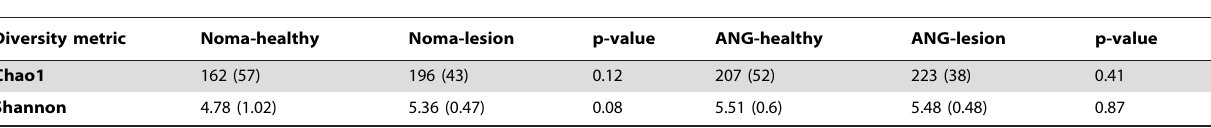
Table 1. Diversity comparisons between lesion and healthy sites*.